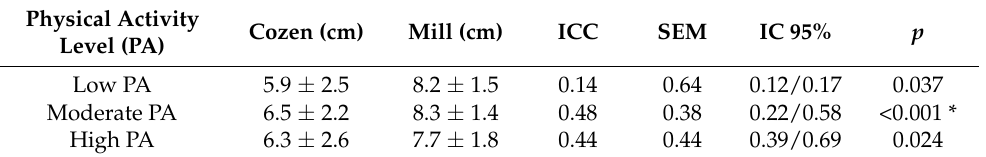
Table 3. Inter-clinical reliability based on the intra-class agreement (ICC) index, standard error of measurement, and confidence interval for the different levels of physical activity (PA): low, moderate, and high in adults with lateral epicondylitis.